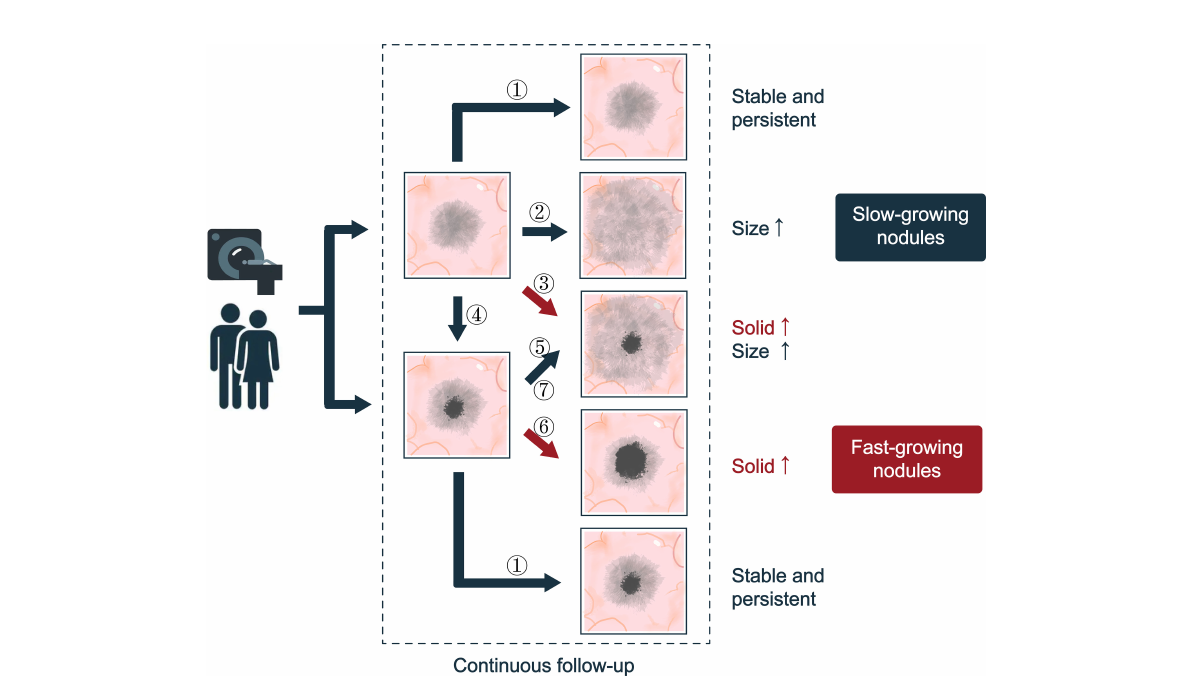
FIGURE 1 The natural history of SSNs. Seven types of progression are suggested: ① No changes; ② Increased ground glass composition in pGGN, and there is no solid component; ③ The diameter of the pGGN increases, and a solid component is produced; ④ the solid component appears with no changes in pGGN size; ⑤ Increased ground glass composition in mGGN and the solid component did not chang; ⑥ Increased solid composition in mGGN and the ground composition did not change; ⑦ The solid and ground glass component of mGGN are increasing. According to the growth rate of ground glass and solid components, SSNs can be divided into fast-growing nodules and slow-growing